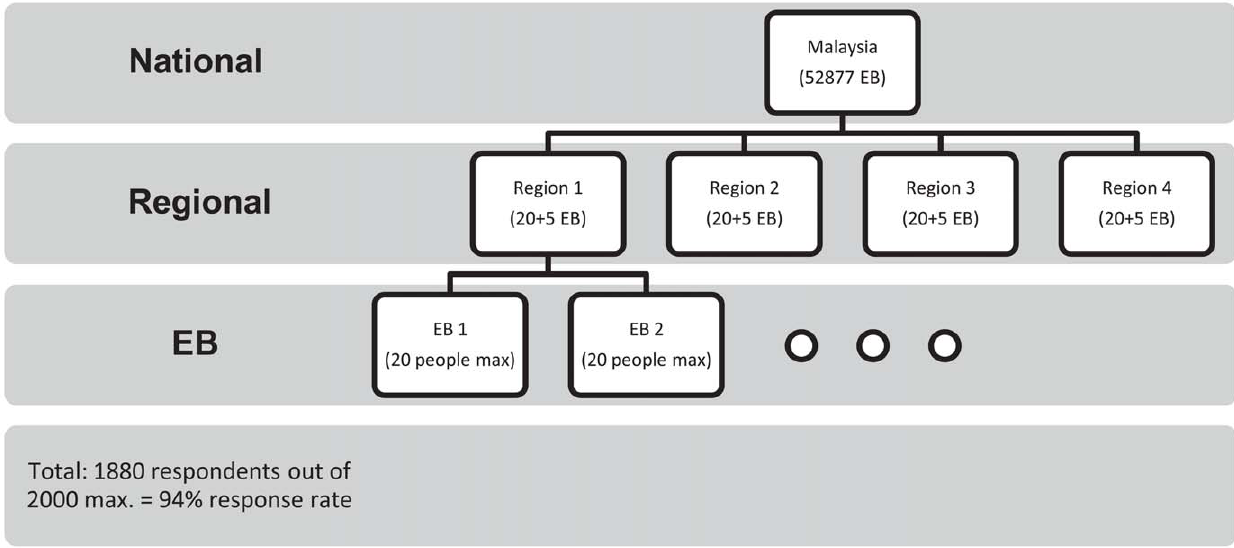
Figure 1. Flow chart showing recruitment process.